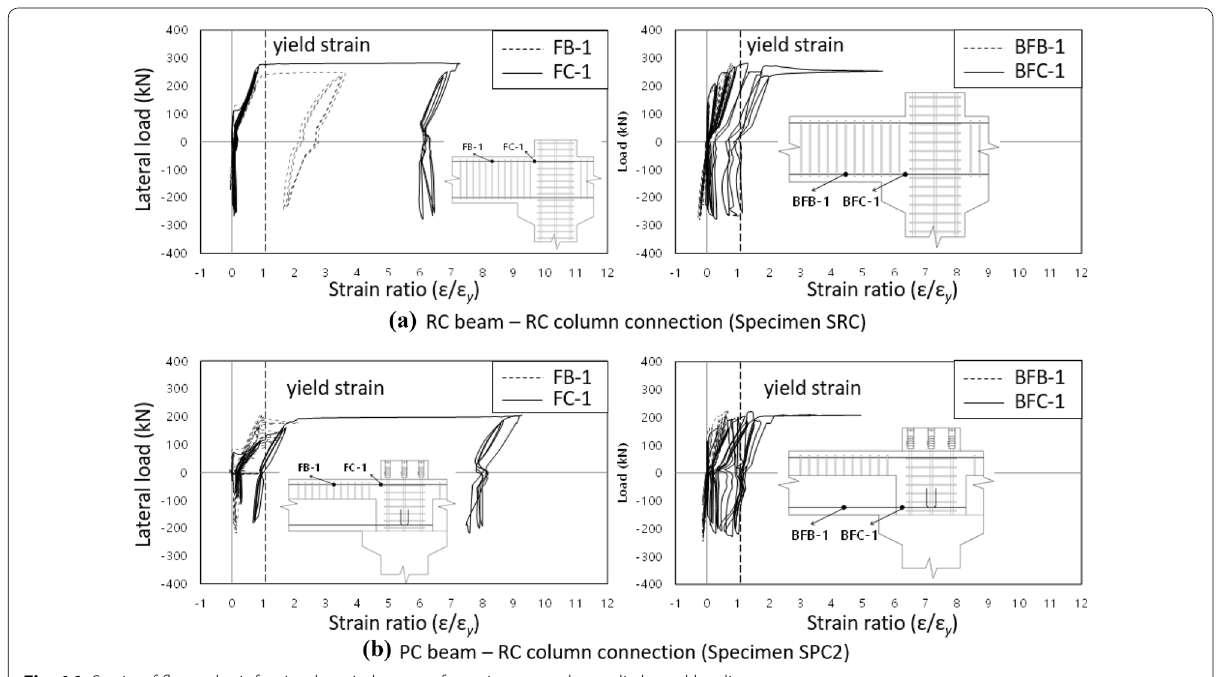
Fig. 16 Strain of flexural reinforcing bars in beams of specimens under cyclic lateral